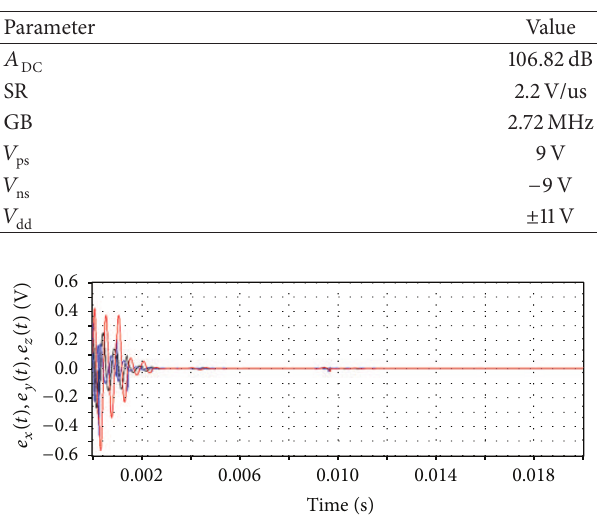
Figure 6: The time responses for the state adaptive synchronization errors 𝑒 𝑥 (𝑡) (red line), 𝑒 𝑦 (𝑡) (blue line), and 𝑒 𝑧 (𝑡) (black